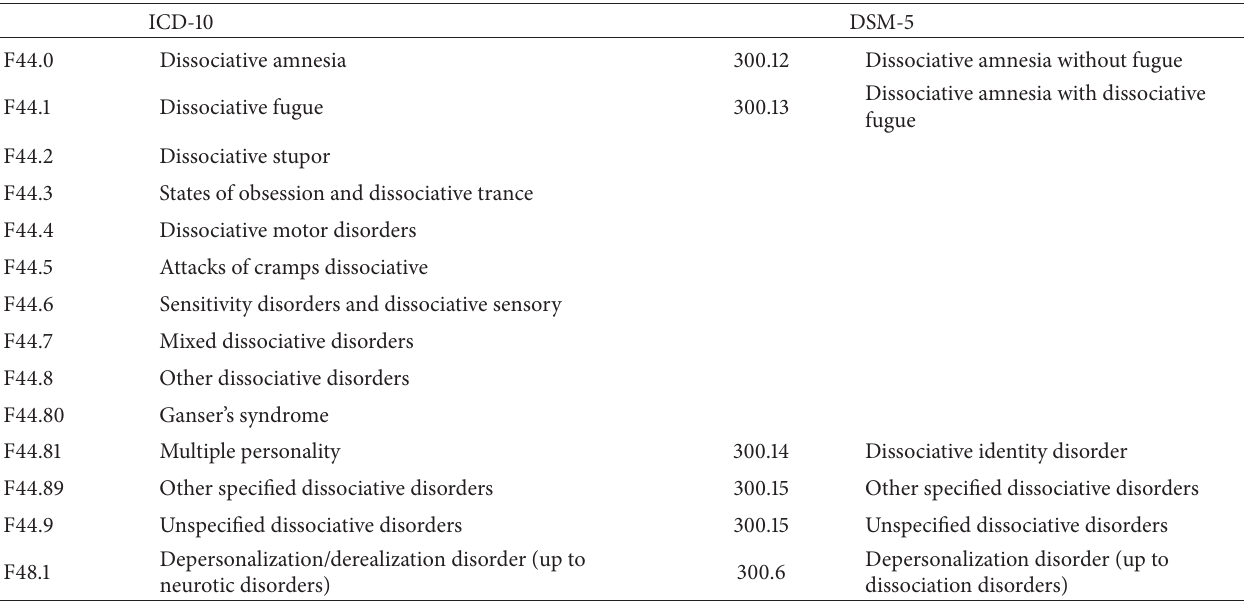
Table 1: Classification of dissociative disorders in ICD-10 and